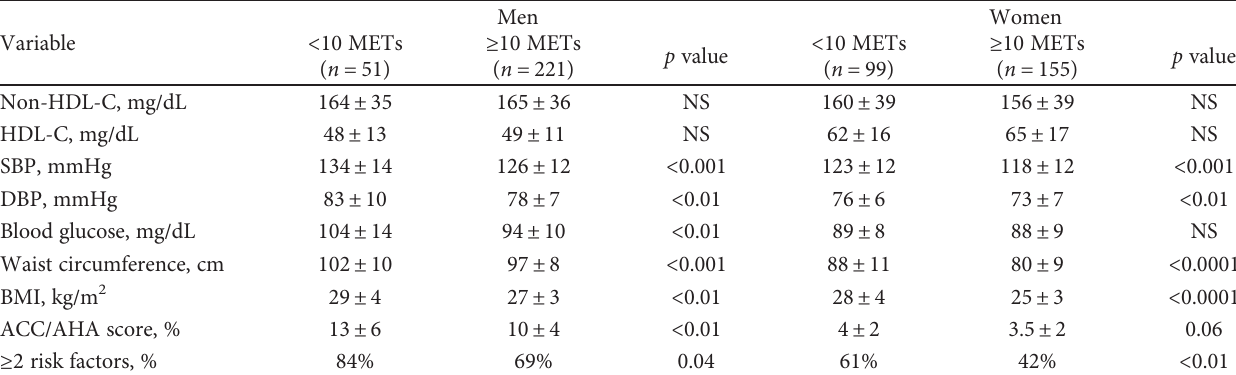
Table 3: Biochemical and anthropometrical variables according to aerobic capacity in subjects between 55 and 64 years old. Variable